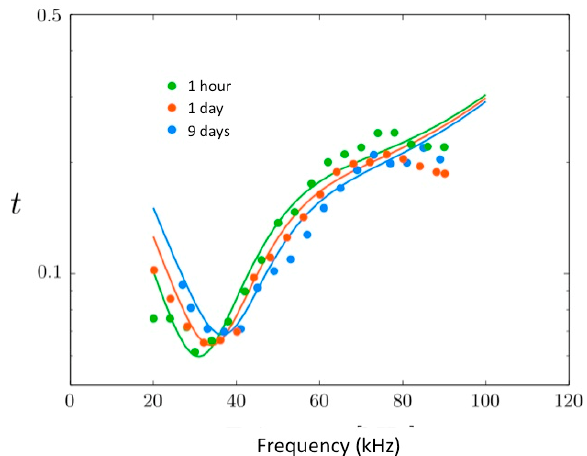
Figure 5. Transmission through the bubble phononic crystal at different times reveals ageing of PDMS. Measurements (full circles) are adjusted by Equation (2) (full lines).